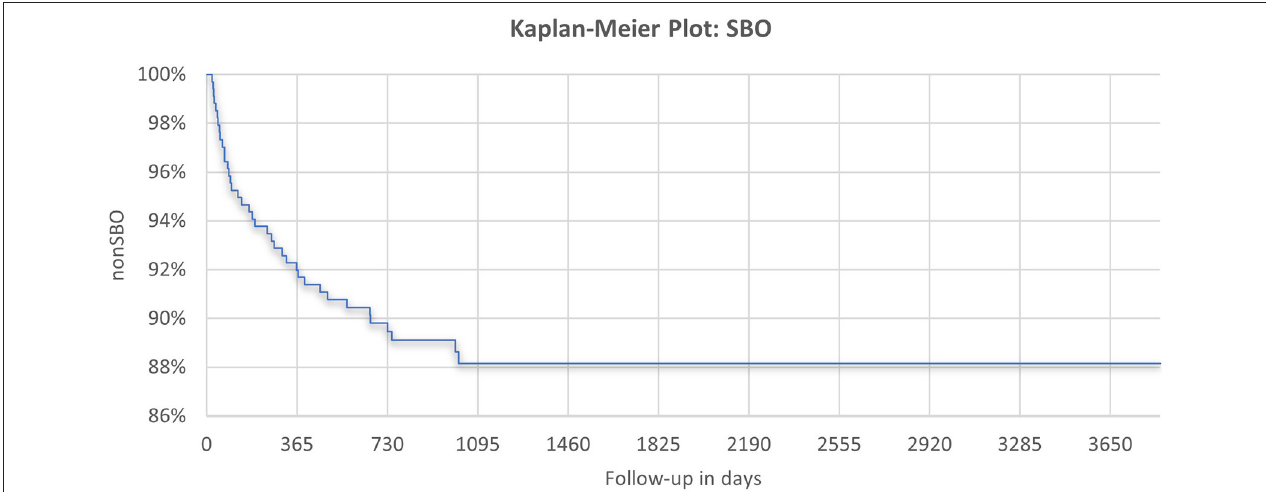
FIGURE 2 | Kaplan–Meier curve for the occurrence of SBO during follow-up with a maximum of 10 years.